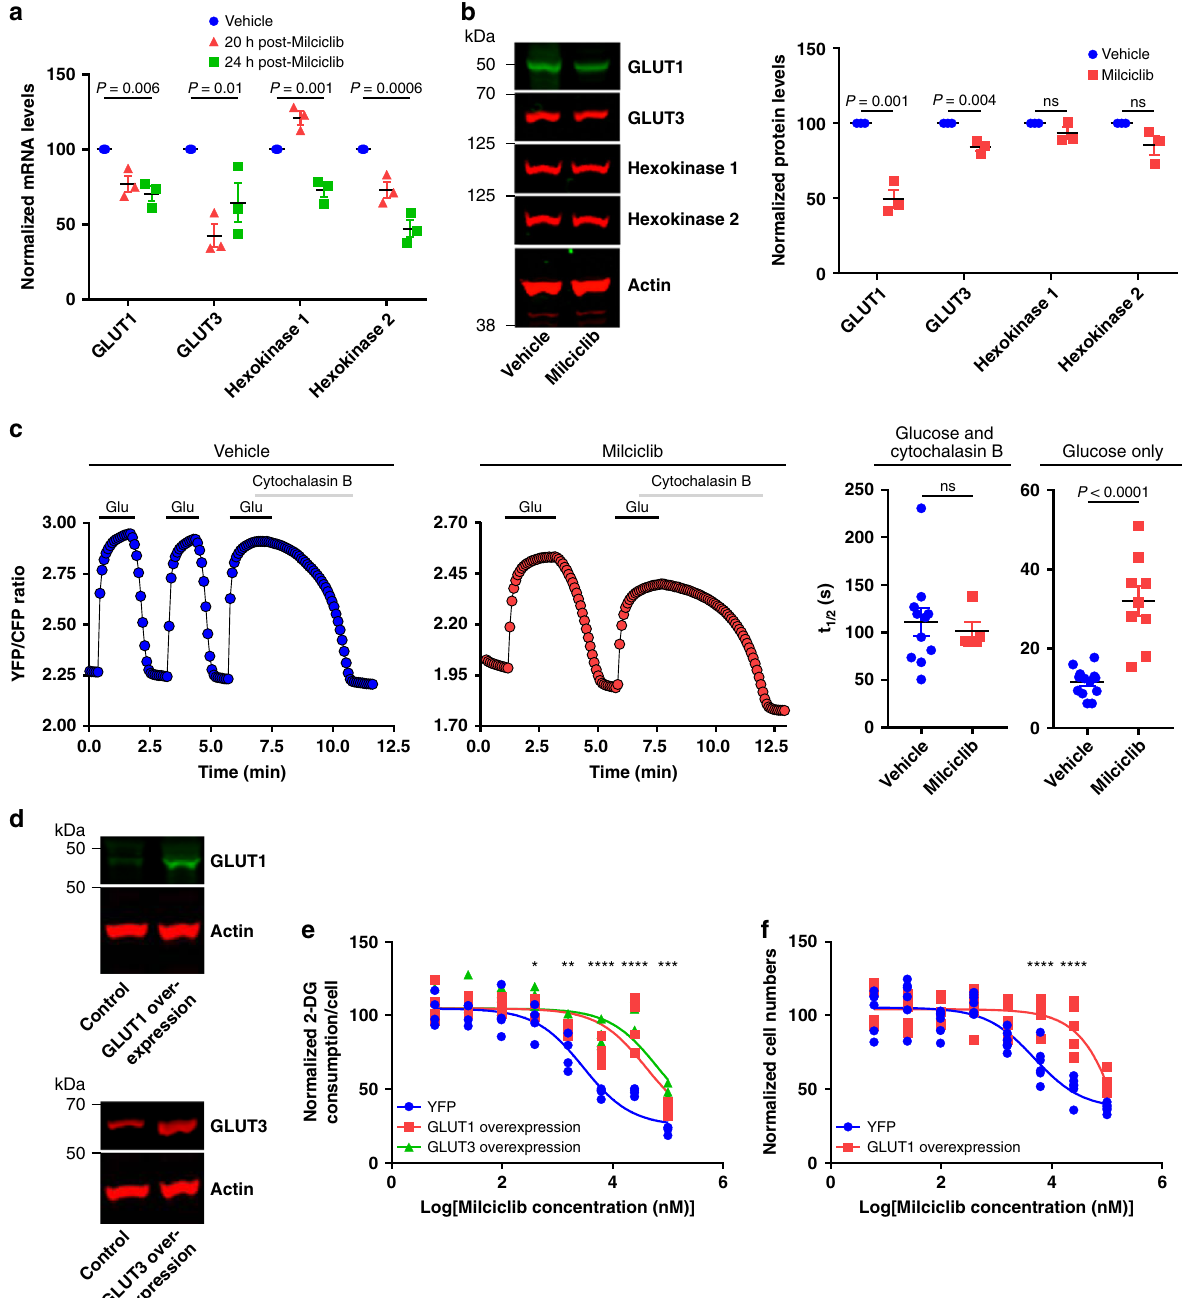
Fig. 4 Milciclib blocks glucose consumption by limiting glucose transport. a mRNA levels from H460 cells treated with vehicle or Milciclib (10 μ M). n = 3. P values determined by one-way ANOVA tests. b Immunoblots (left) and quanti fi cation (right) of lysate from H460 cells treated with vehicle or Milciclib (10 μ M). n = 3. P values determined by unpaired t tests. c Representative FRET traces (left and middle) and quanti fi cation (right) of H460 cells treated with vehicle or Milciclib (10 μ M). Glu: glucose. Glucose and Cytochalasin B: Vehicle, n = 11; Milciclib, n = 5. Glucose only: Vehicle, n = 13; Milciclib, n = 9. P values determined by unpaired t tests. d GLUT1 and GLUT3 protein levels in H460 cells transfected with a control (YFP) or a GLUT1 or GLUT3 overexpression plasmid. n = 2. e Glucose consumption dose response curves in H460 cells that overexpress YFP, GLUT1, or GLUT3 and that were treated with Milciclib. n = 4. P values determined by a two-way ANOVA test. f Cell growth dose response curves in H460 cells that overexpress YFP or GLUT1 and that were treated with Milciclib for 48 h. n = 6. P values determined by a two-way ANOVA test. ns: not signi fi cant. * P < 0.05; ** P < 0.01; *** P < 0.001; **** P < 0.0001. Data are plotted as mean ±